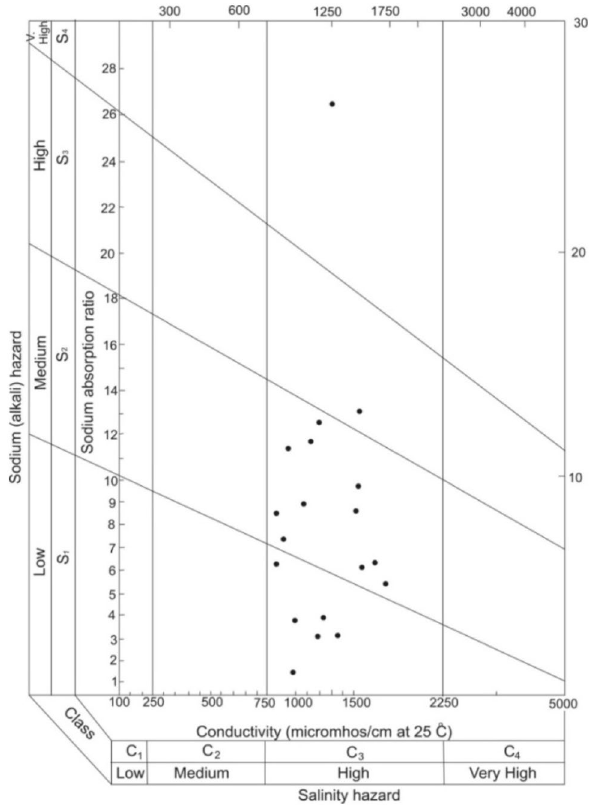
Fig. 8 US salinity diagram for classification of irrigation waters